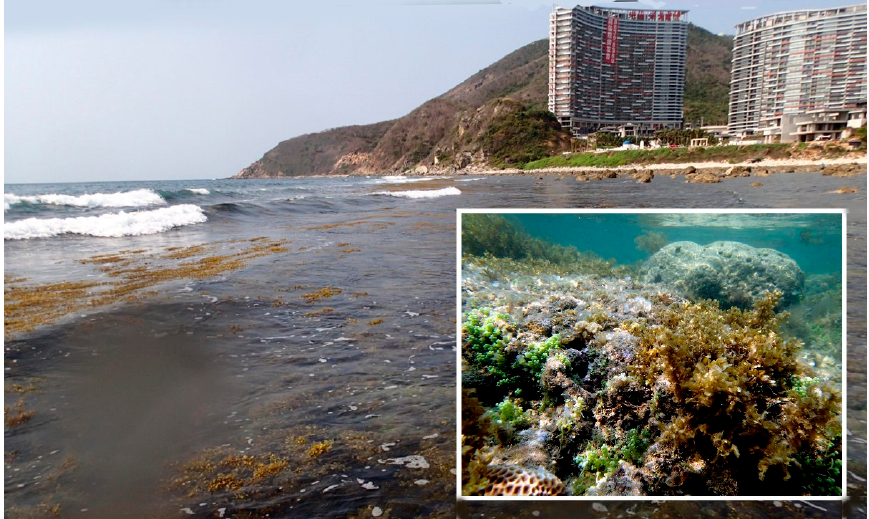
Figure 3. Xiaodong Hai, Sargassum spp. belt along the coast. Inset: The upper subtidal zone. March 2015.